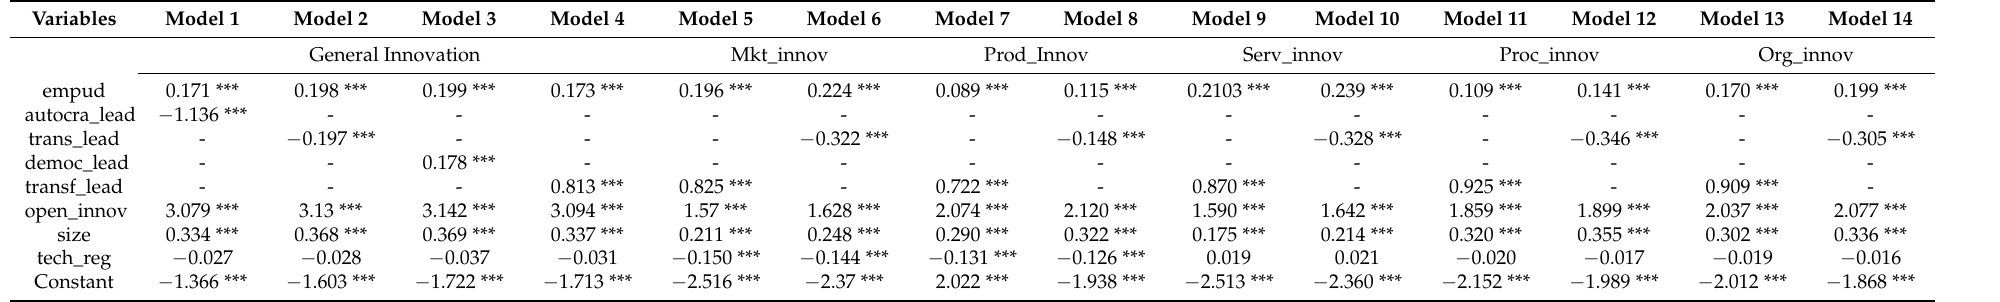
Table 5. Econometric Estimations.